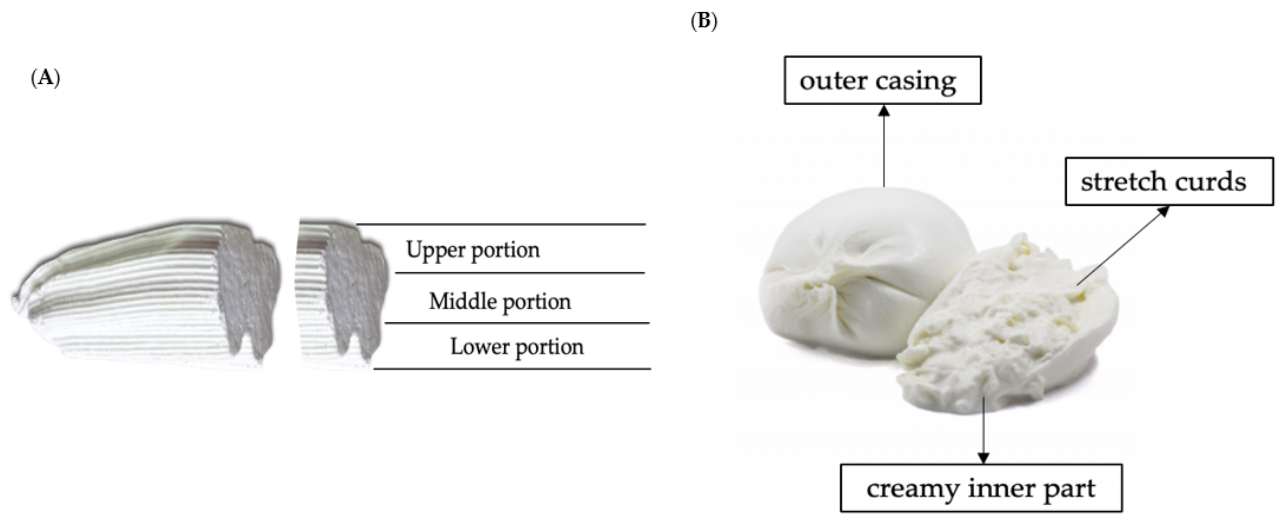
Figure 2. Italian cheeses studied for vitamin D 3 enrichment: ( A ) giuncata cheese; ( B ) burrata cheese. The macronutrient compositions of cheeses (giuncata and burrata) are reported in Table 4. The total proteins were determined by the Kjeldahl method, salt analysis was performed by the Volhard method, and lipid levels were assessed by extraction with petroleum ether. Then, the solvent was evaporated to dryness at 95–100 ◦ C and weighed according to the AOAC official method (n ◦ 2011.14 for protein analysis, n ◦ 935.43 for salt, and n ◦ 974.09 for fat) [36]. The total carbohydrates and energy values were calculated by differences. Table 4. Nutrition facts of burrata and giuncata cheese. Burrata